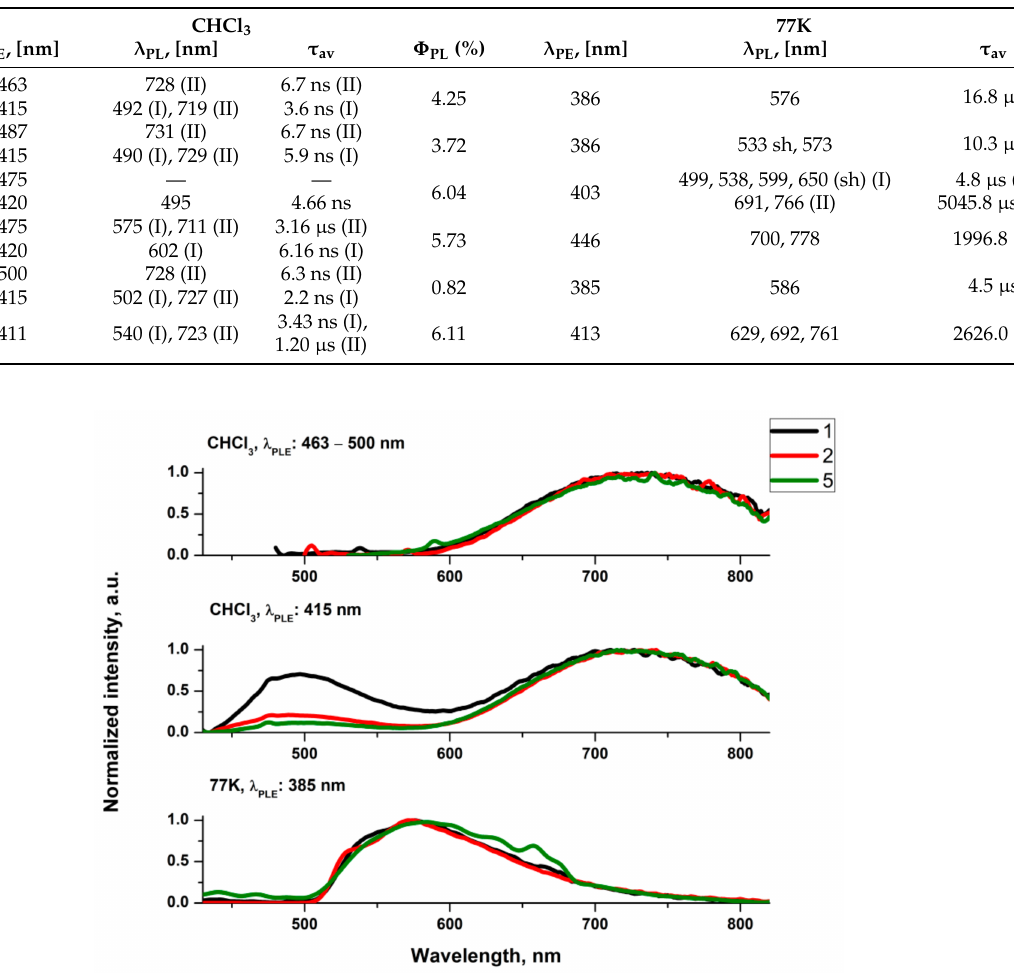
Table 2. Emission spectral data of 1 – 6 .